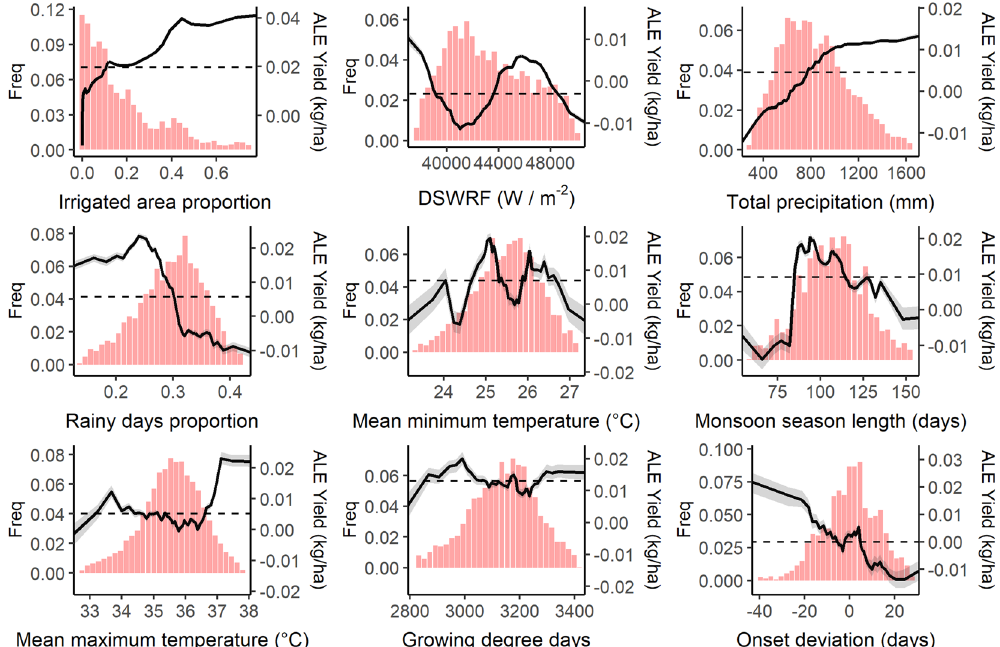
ribbons represent 95th percentile ALE. Histograms show the distribution of the 98th percentile of predictor data in the original full dataset prior to sub-sampling for the random forest modelling. Note that y-axis ALE values are contingent on input data and are not directly comparable. Y axis scale varies between each sub-plot to highlight response curve shapes.